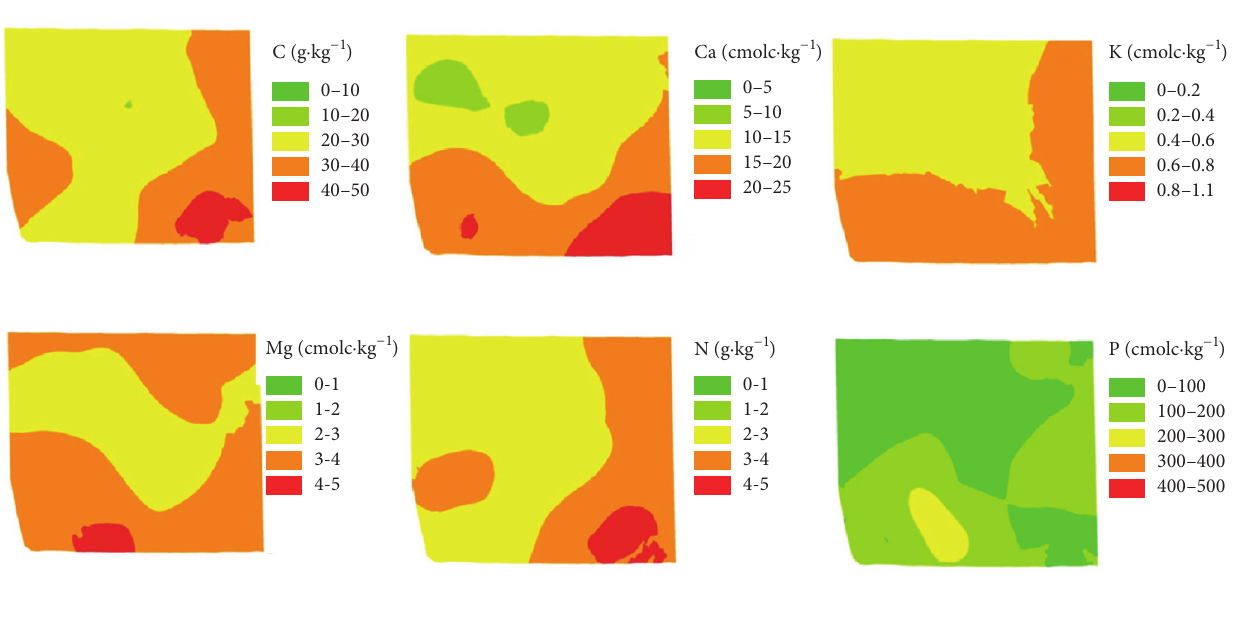
Figure 6: Spatial distribution of nutrients in the soils of vineyard 3 (horizon